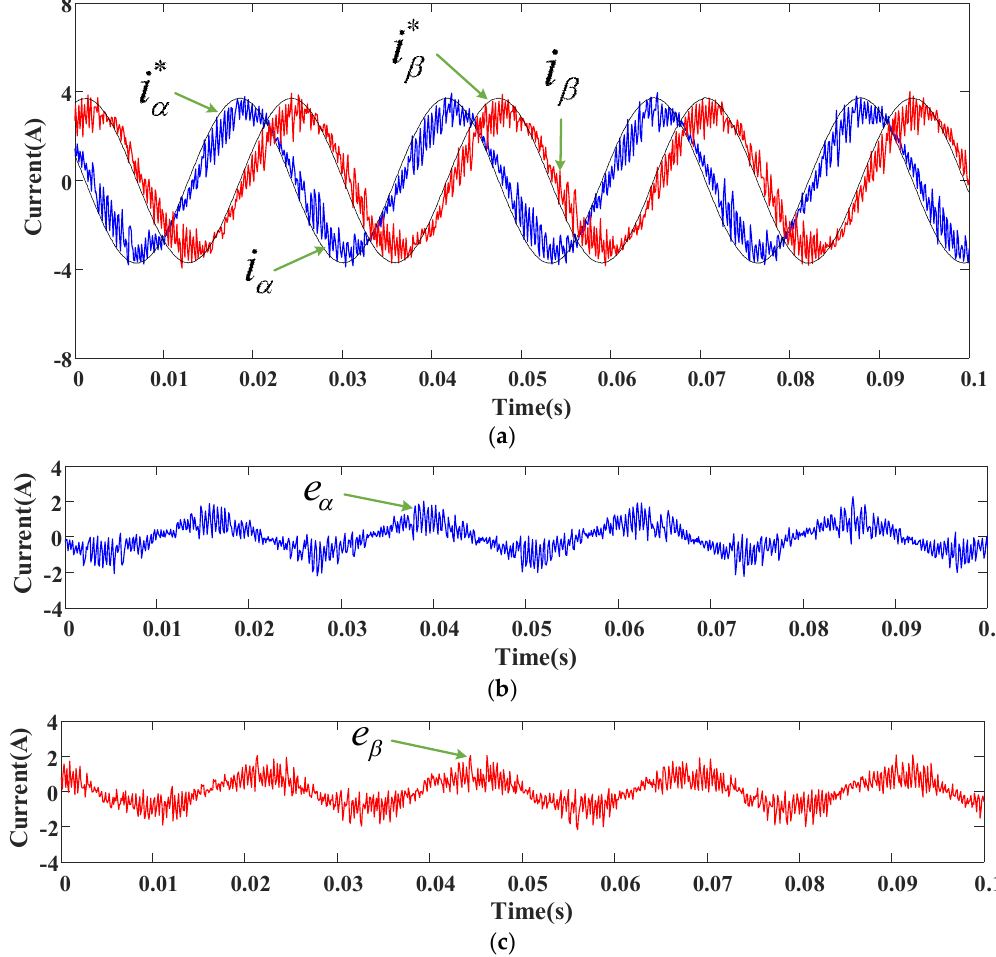
Figure 21. Experimental results of DVV-MPCC under speed 1300 rpm and load 1 Nm (case 4): ( a ) current responses; ( b ) α -axis current error; ( c ) β -axis current error.